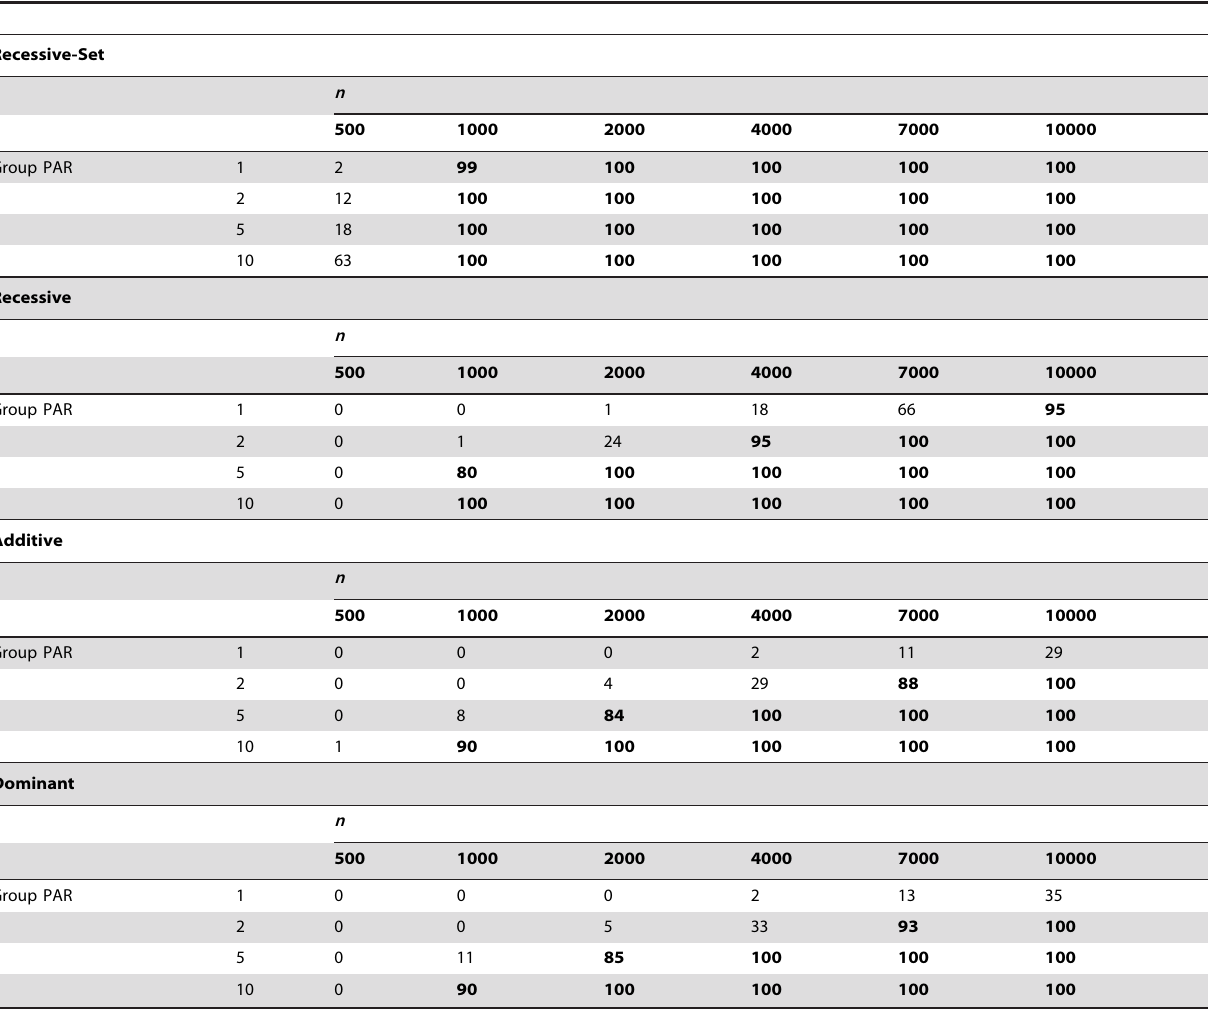
Table 1. Number of individuals needed to identify a disease-associated group.